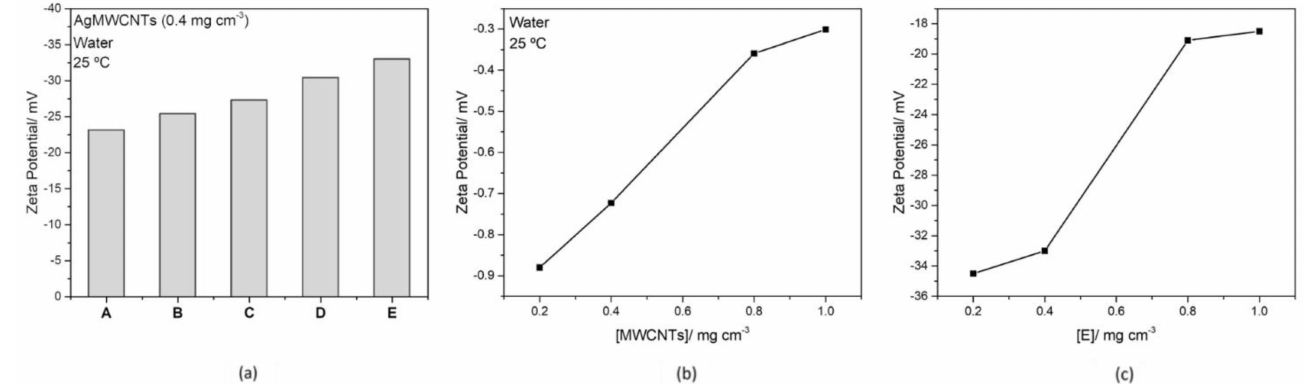
Figure 2. Zeta potential (ZP) for different AgMWCNTs samples (0.4 mg cm − 3 ) ( a ), different MWCNTs concentrations ( b ) and different concentrations of Sample E ( c